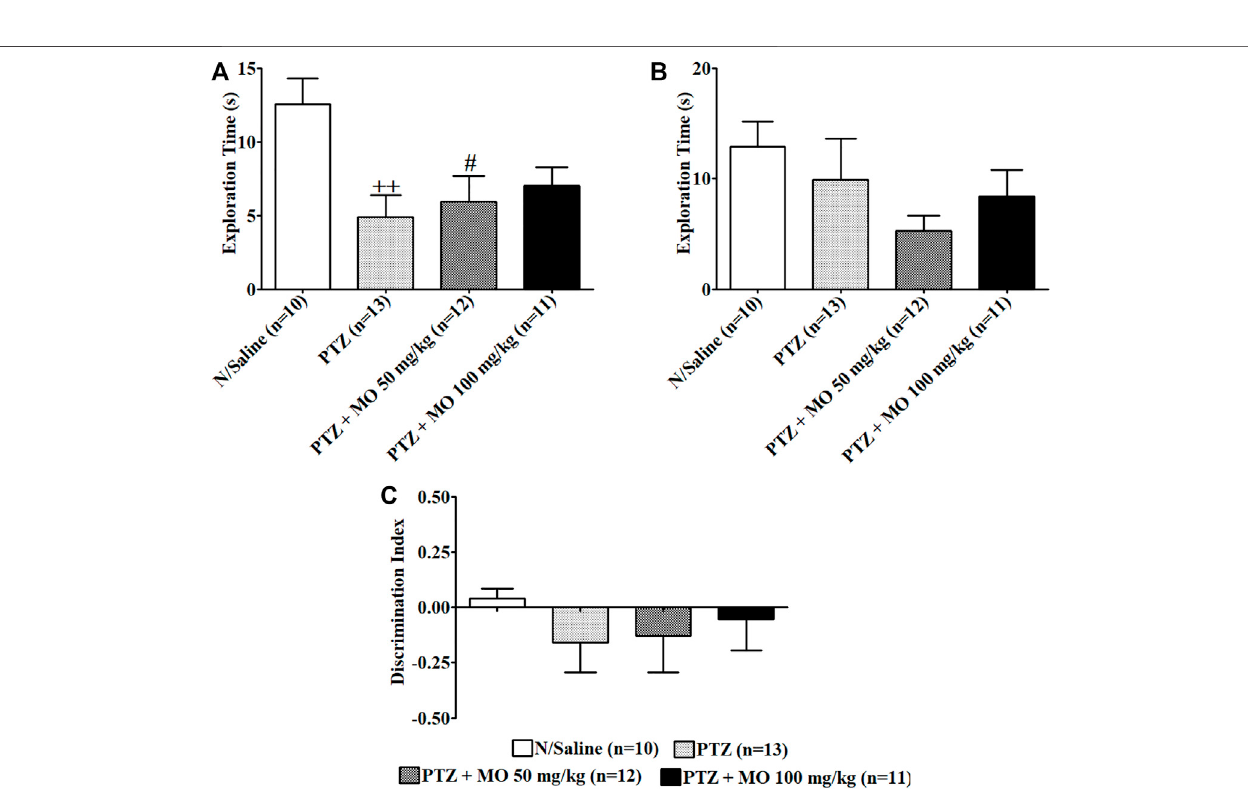
FIGURE8| Effectsof Melissaof fi cinalis L.essentialoil(MO)onnovelobjectrecognitiontestinPTZ-kindledrats. (A) Durationofexplorationofthenovelobject++ p < 0.01(N/SalinevsPTZ);# p < 0.05(N/SalinevsPTZ+MO50 mg/kg); (B) Durationofexplorationoffamiliarobject; (C) DiscriminationIndex. n (cid:2) numberofanimalstested. Mean ±